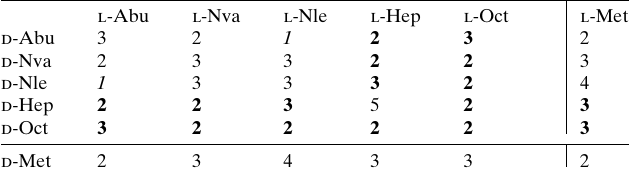
Table 1 Overview of the number of enantiotropically related polymorphs known for the aliphatic linear-chain amino acid (quasi)racemates studied here.